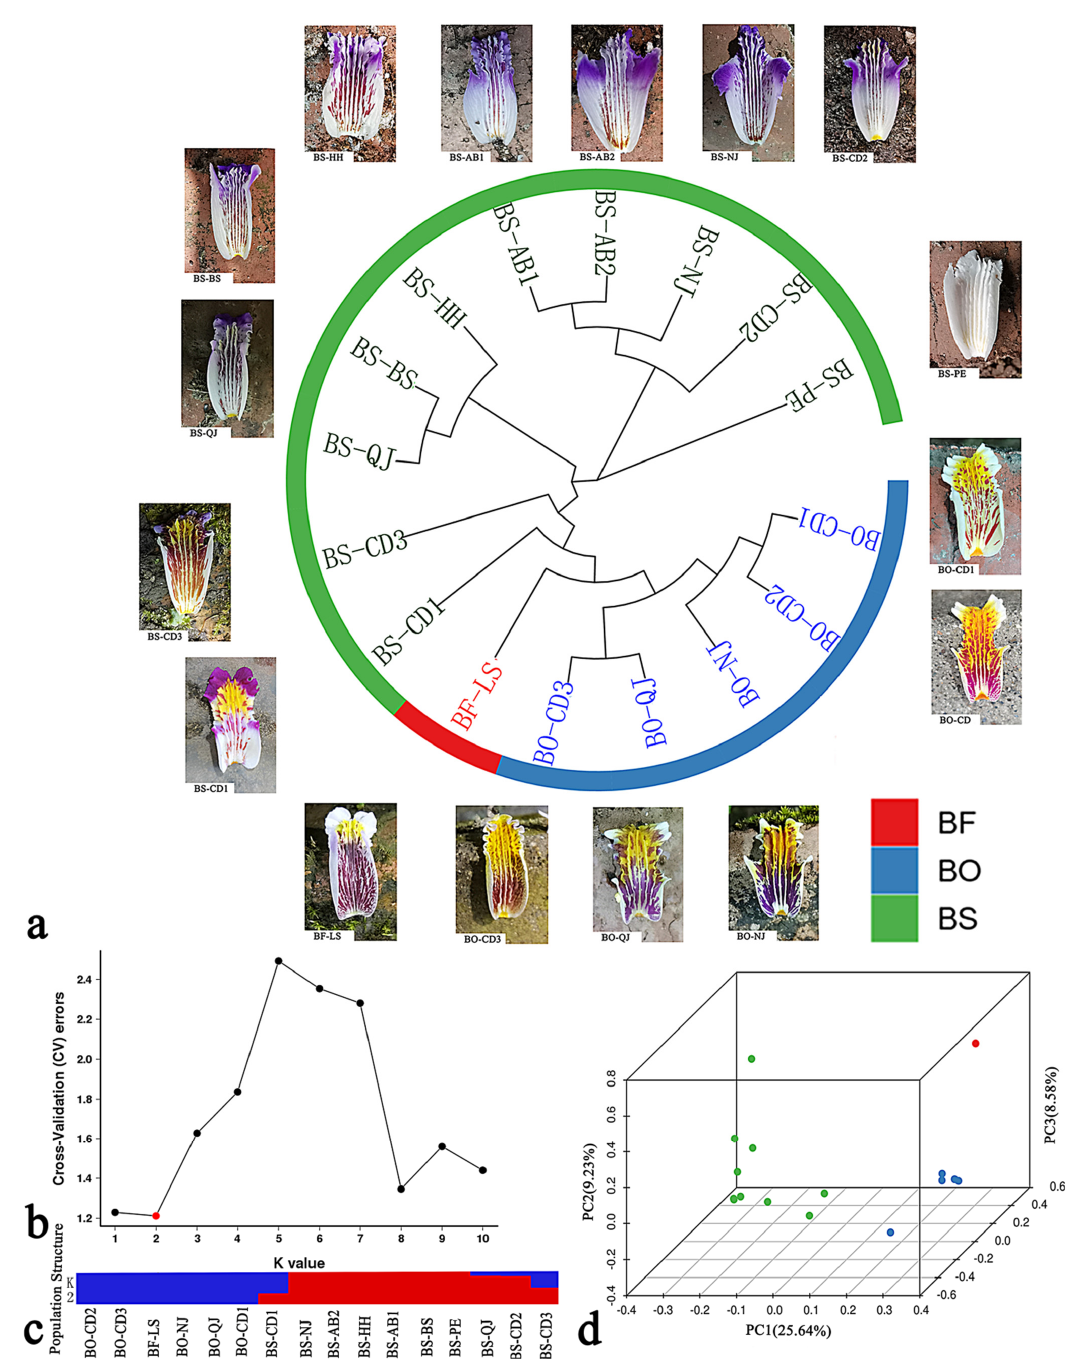
Figure 2. ( a ) Phylogenetic tree; ( b ) Cross-validation error rate of each k value of admixture; ( c ) Cross-validation error rate of each k = 2 value of admixture; ( d ) Three-dimensional cluster diagram (PC1, PC2, and PC3). BS-AB1: B. striata from Aba, Sichuan No 1; BS-AB2: B. striata from Aba, Sichuan No 2; BS-CD1: B. striata from Dujiangyan, Sichuan No 1; BS-CD2: B. striata from Pengzhou, Sichuan No 2; BS-CD3: B. striata from Chongzhou, Sichuan No 3; BS-NJ: B. striata from Neijiang, Sichuan; BS-BS: B. striata from Baoshan, Yunnan; BS-HH: B. striata from Honghe, Yunnan; BS-PE: B. striata from Pu’er, Yunnan; BS-QJ: B. striata from Qujing, Yunnan; BO-CD1: B. ochracea from Jingtang, Sichuan No 1; BO-CD2: B. ochracea from Dujiangyan, Sichuan No 2; BO-CD3: B. ochracea from Dujiangyan, Sichuan No 3; BO-NJ: B. ochracea from Neijiang, Sichuan; BO-QJ: B. ochracea from Qujing, Yunnan; BF-LS: B. formosana from Leshan,